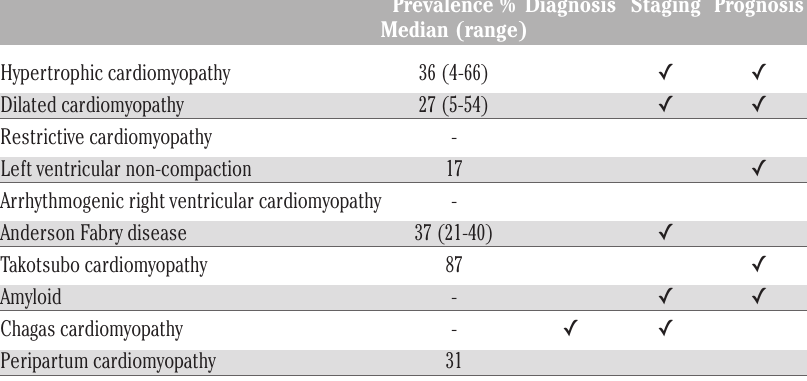
Table 6. Summary of the role of troponin measurement in cardiomyopathy. Staging refers to the association of elevated troponin levels with clinical markers of advanced disease. See text for